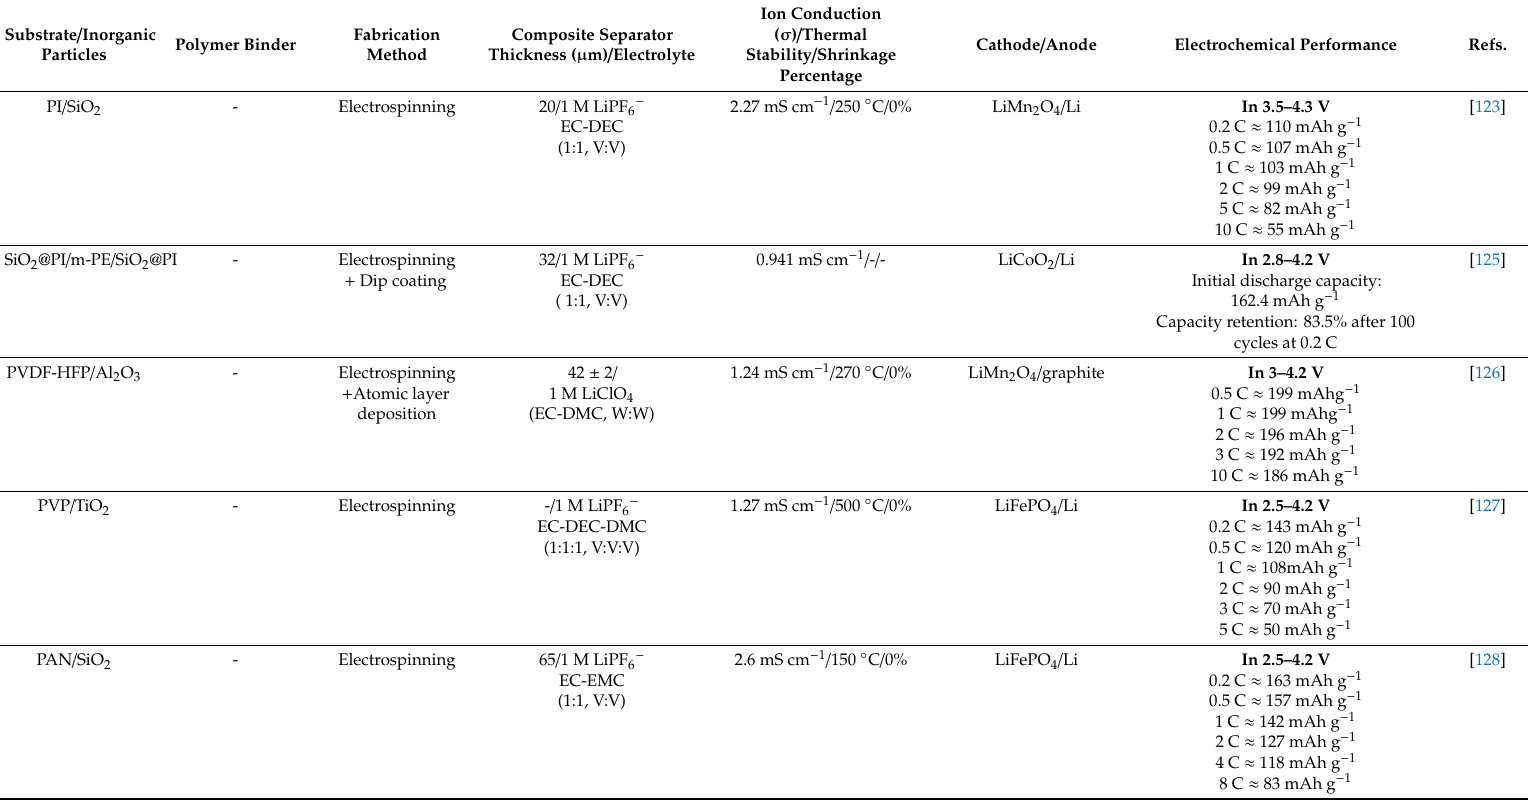
Electrochemical